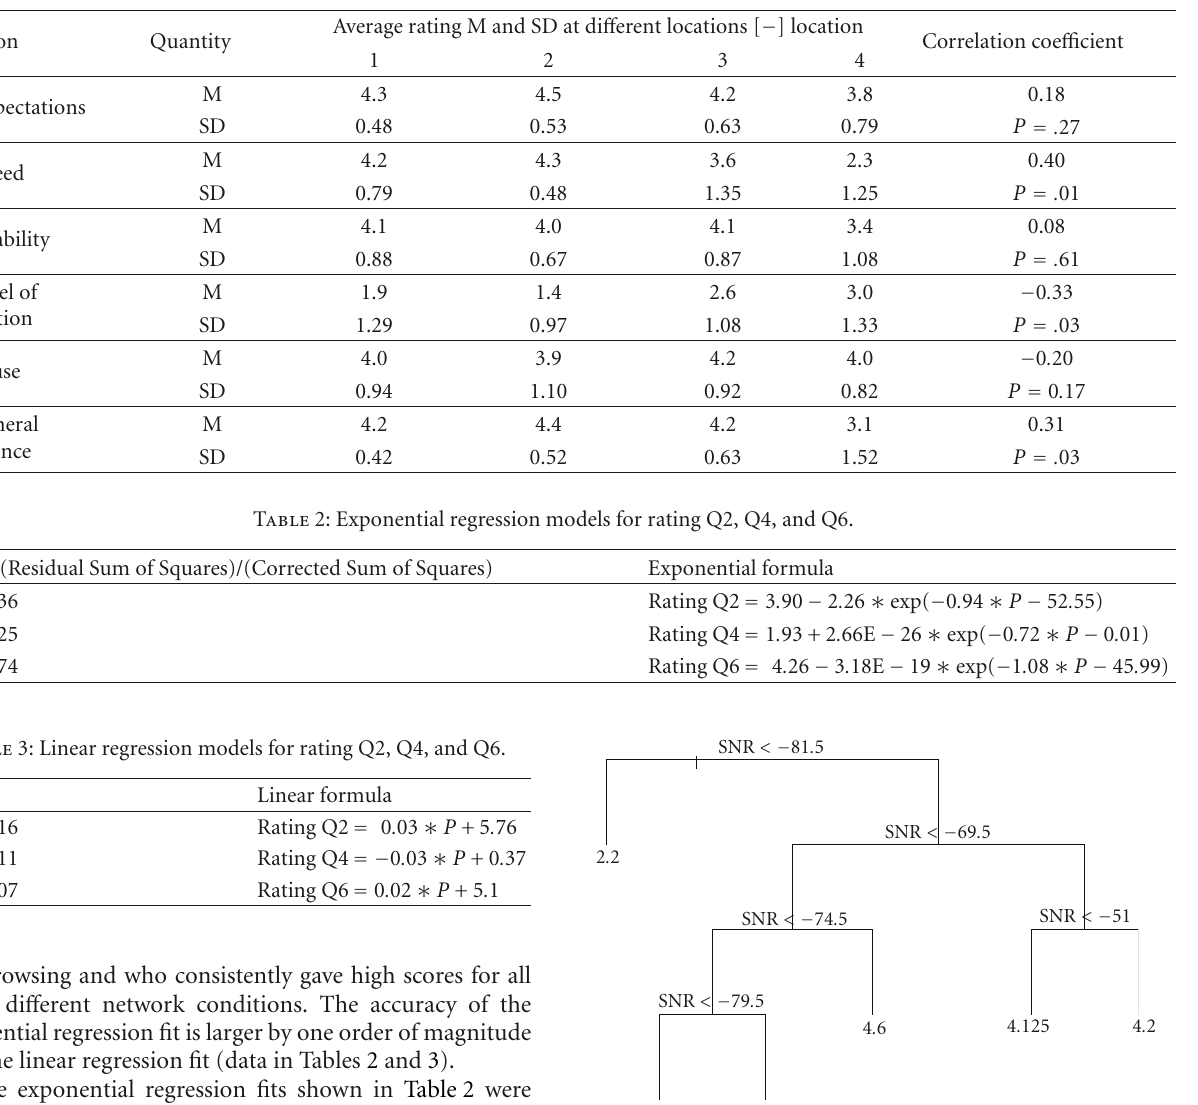
Table 1: Average ratings and standard deviations for ratings of di ff erent locations by all users.